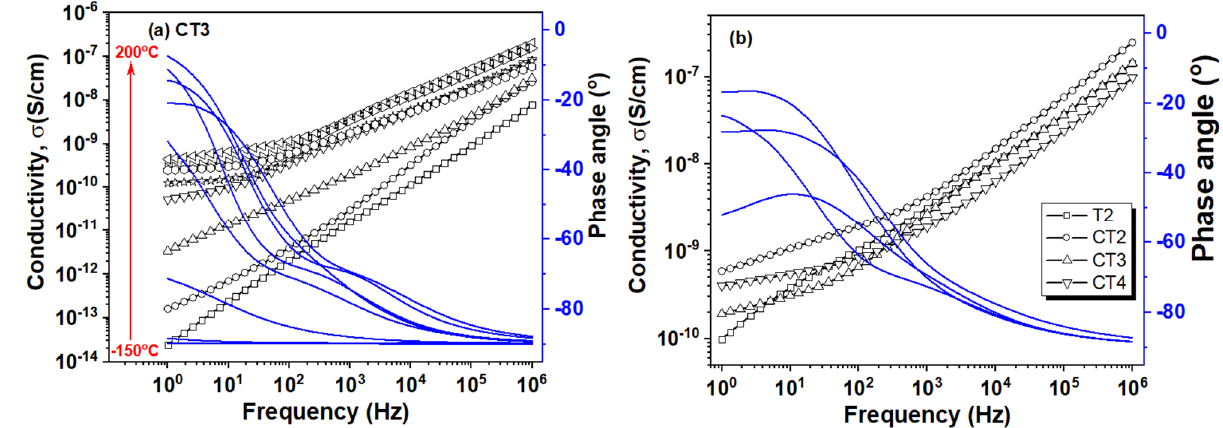
Figure 10. The evolution of dielectric loss as a function of frequency: ( a ) exemplarily for CT2 at various temperatures and ( b ) comparatively for all examined samples at room temperature.